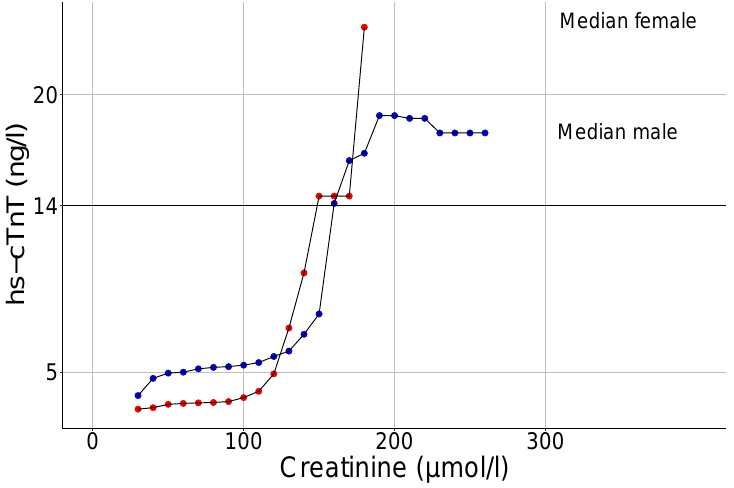
Figure 3. Floating median hs-cTnT values in relation to serum creatinine (window size of +/ − 15 µ mol/L per point, steps of 10 µ mol/L) in females (red curve) and males (blue curve). Increas- ing serum creatinine values correlate with higher median hs-cTnT concentrations. Hs-cTnT: highly sensitive troponin T.